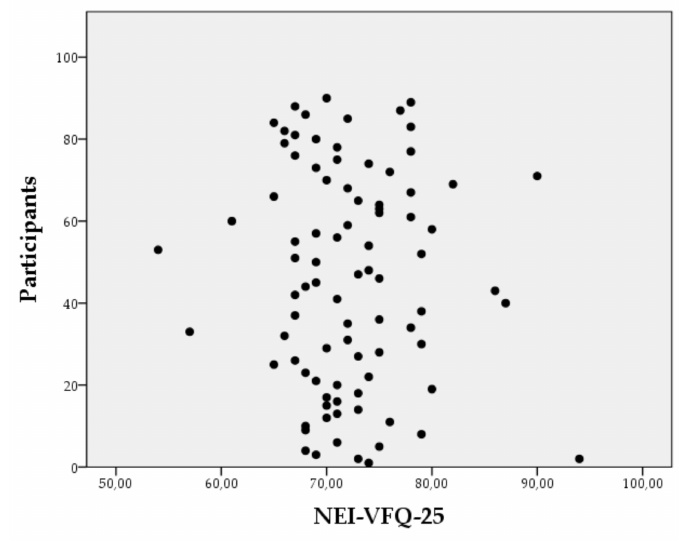
Figure 2. Distribution of the participants’ total score on the NEI-VFQ-25. Table 2. Analysis of the mean ranges of the subscales and total score of the NEI-VFQ-25 according to the categorical